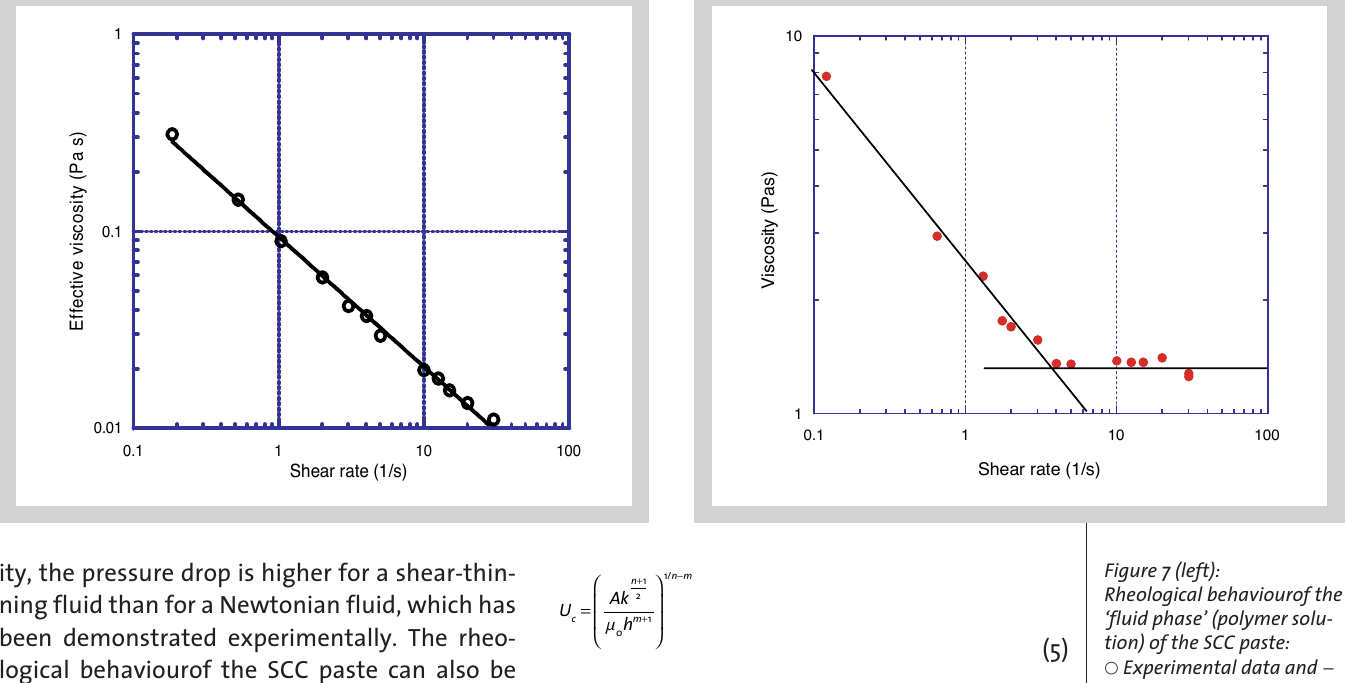
Figure 7 (left): Rheological behaviourof the ‘fluid phase’ (polymer solu- tion) of the SCC paste: Á Experimental data and - power-law fit. Figure 8: Rheological behaviourof SCC paste in shear flow (determined using a Couette